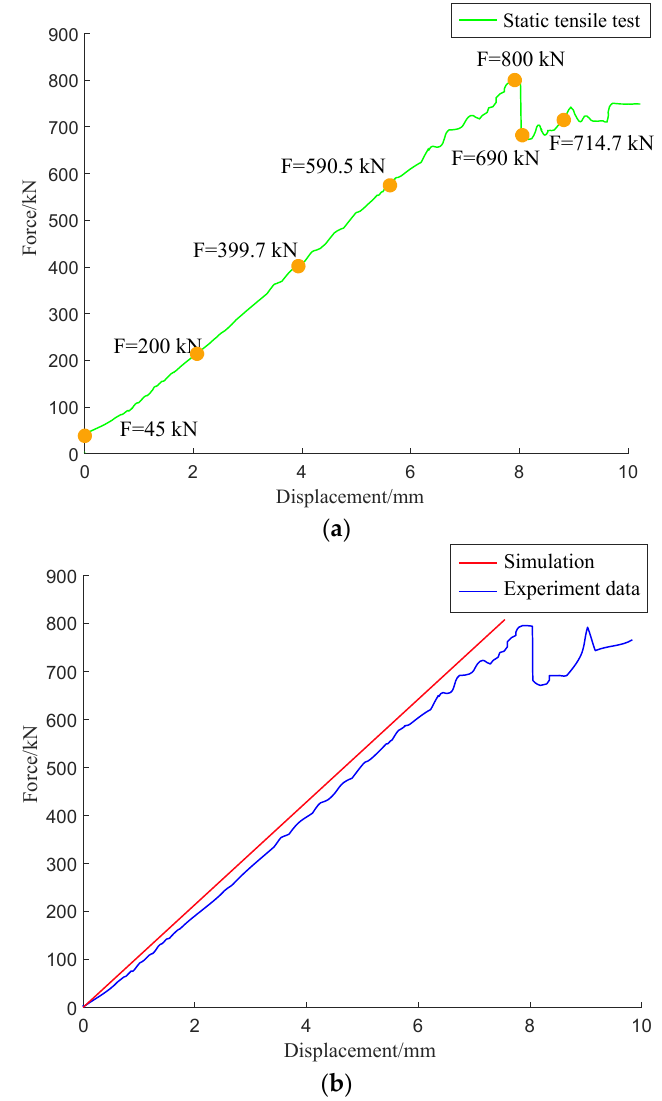
Figure 12. Force-displacement curve: ( a ) force sensor curve; ( b ) test-simulation curve.